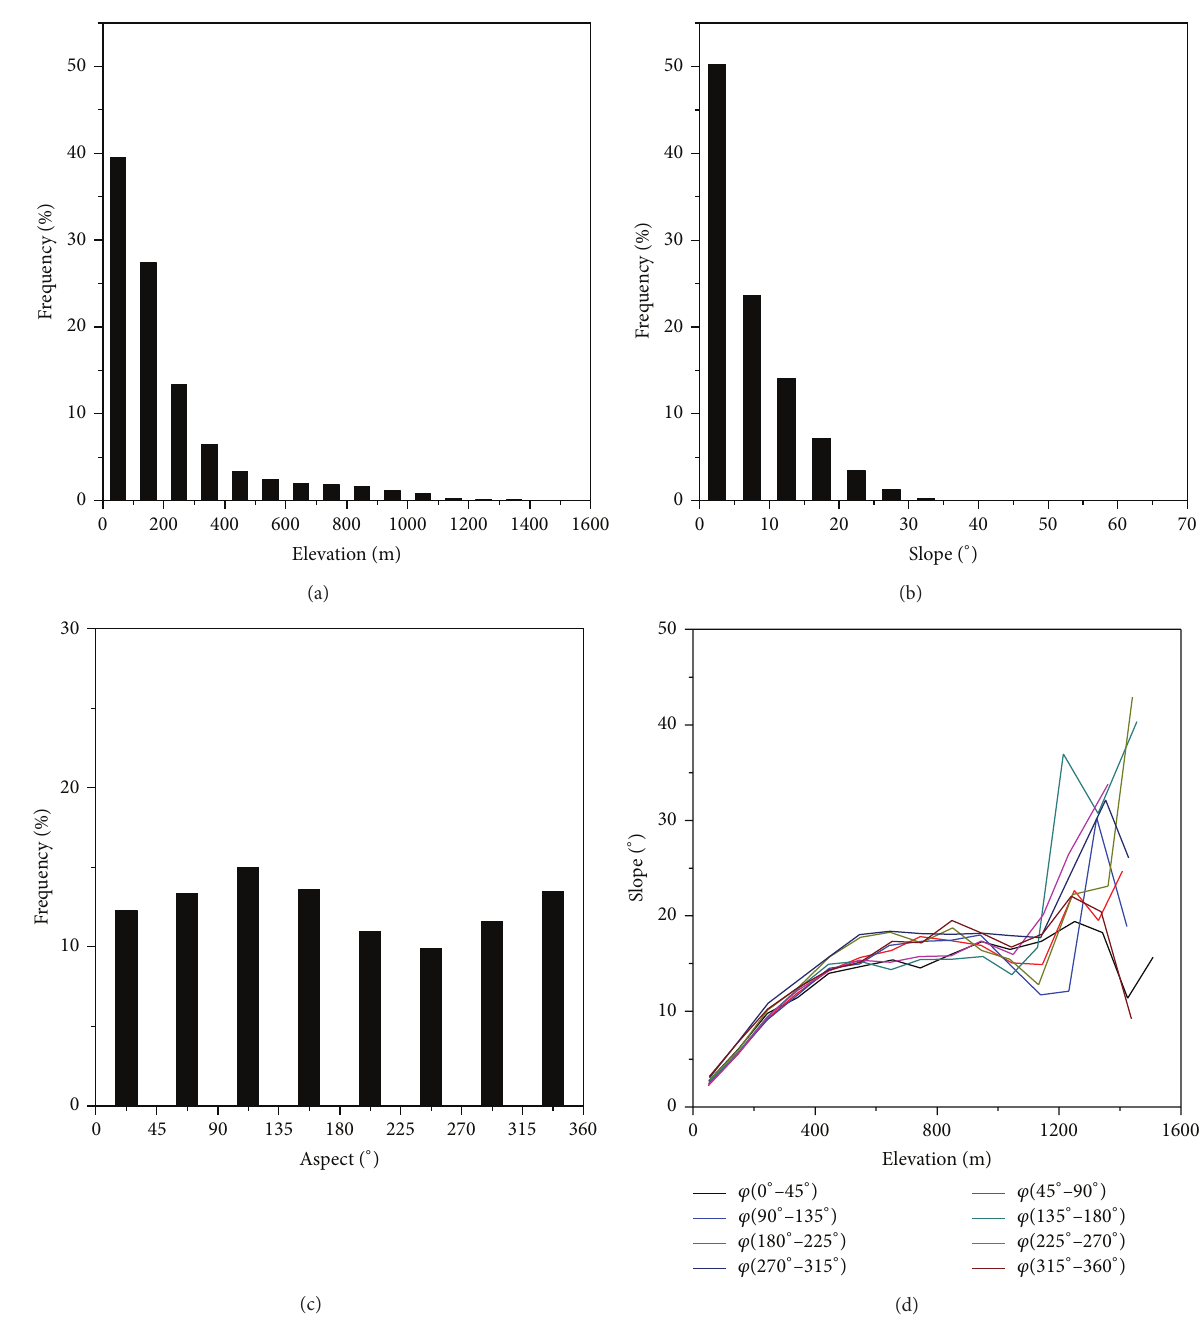
Figure 2: Frequency distributions of the (a) elevation, (b) slope, (c) aspect angle of terrain and (d) relationship between the elevation and slope over the selected Taihu Basin